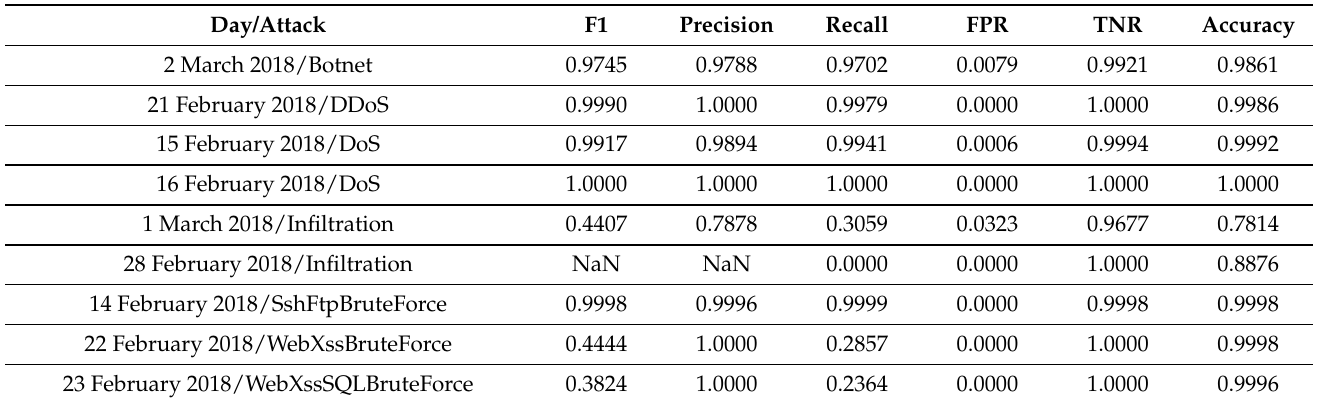
Table 11. Results obtained with a training LSTM and autoencoder.